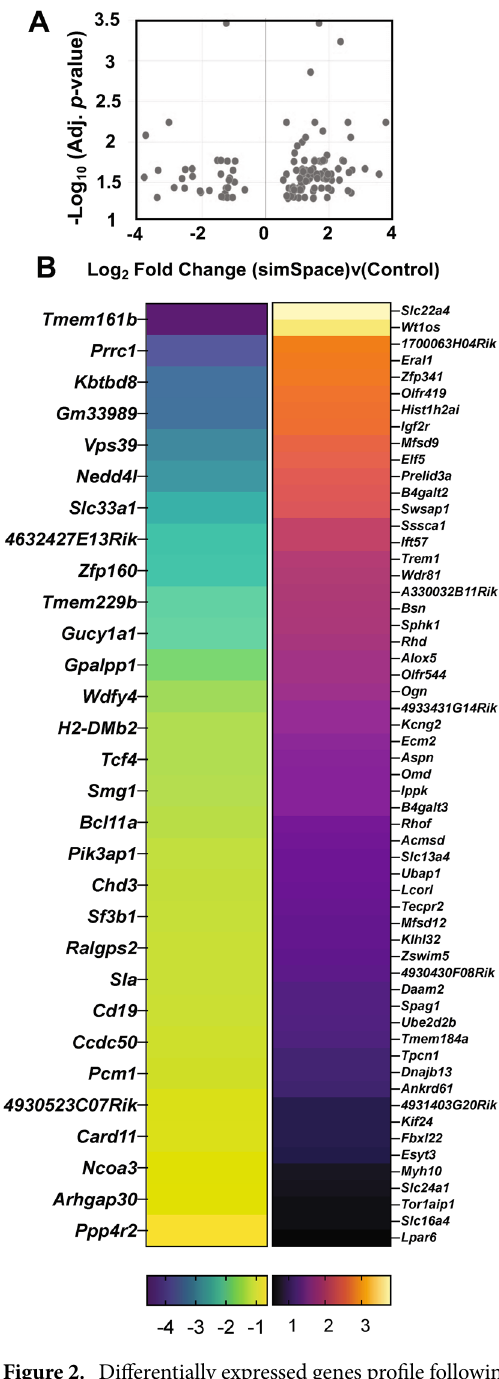
Figure 2. Differentially expressed genes profile following 7-days post-simulated spaceflight. ( A ) Volcano plot displaying Log 2 fold change cutoff (0.263) compared to -Log 10 (adjusted p -value, 0.05) adapted from GeneLabs visualization tool 23 of simSpace versus controls. ( B ) Modified heatmap of downregulated (left panel) and upregulated (right panel) differentially expressed genes of simSpace versus controls (scale bar below panel). Data represents n = 6 per